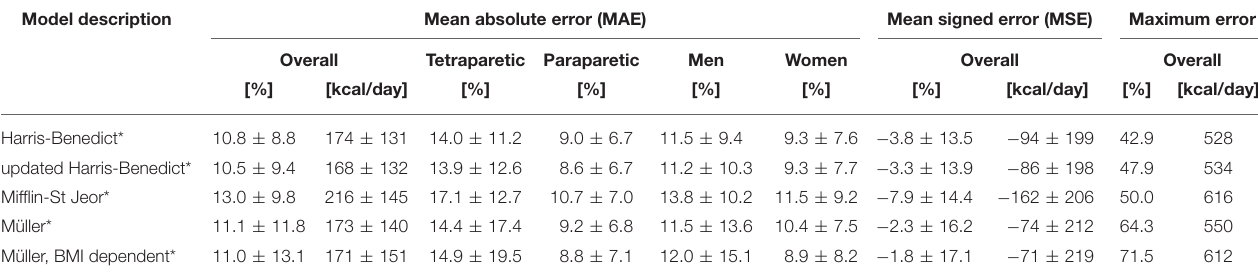
TABLE 3 | Results of the resting energy expenditure (REE) estimation based on existing models from the literature. Model description